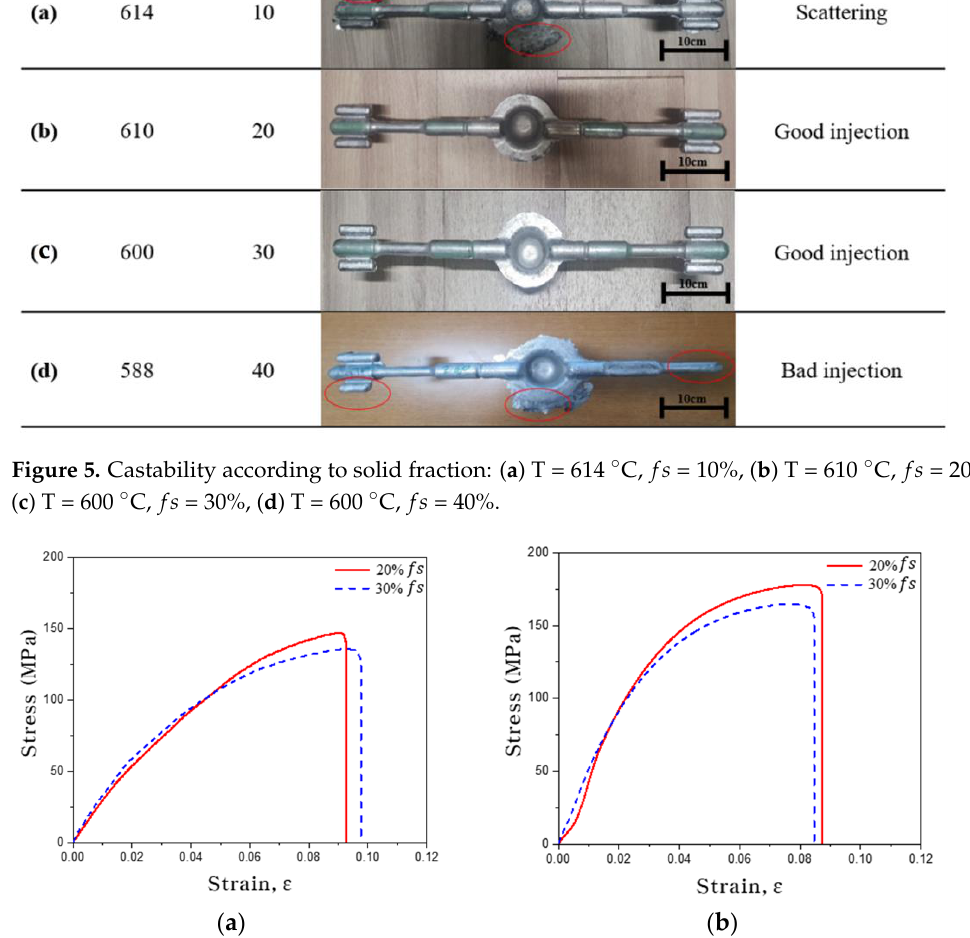
Figure 6. Stress – strain curve according to current input method: ( a ) DC, ( b ) AC.